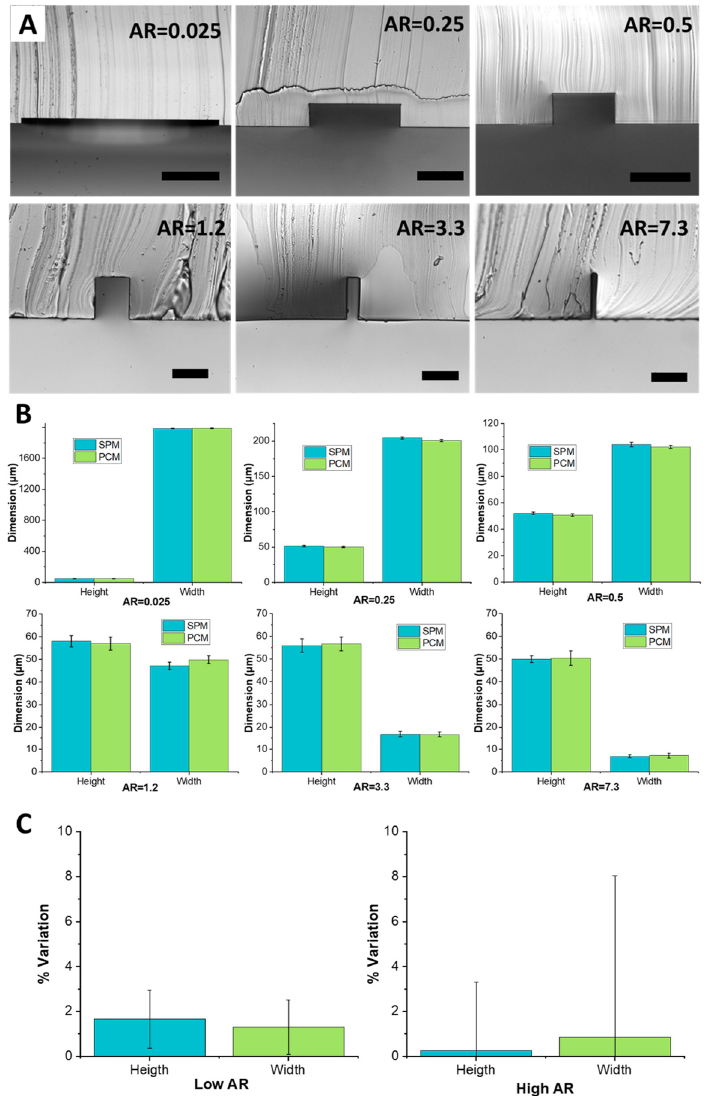
Figure 3. PDMS replicas of channels of various aspect ratios formed using PCMs. ( A ) Cross-sectional images of channels formed from PCMs. The channel dimensions were: 2000 µm × 50 µm (AR = 0.025, scale bar is 500 µm), 200 µm × 50 µm (AR = 0.25, scale bar is 100 µm), 100 µm × 50 µm (AR = 0.5, scale bar is 100 µm), 58 µm × 47 µm (AR = 1.2, scale bar is 50 µm), 56 µm × 17 µm (AR = 3.3, scale bar is 50 µm), and 50 µm × 7 µm (AR = 7.3, scale bar is 50 µm). ( B ) Quantitative comparison of the cross-sectional dimensions ( n = 5). ( C ) Variability of cross-sectional dimensions along the 4 cm channel length for low aspect ratio (AR < 1) and high aspect ratio (AR > 1) channels ( n = 5).